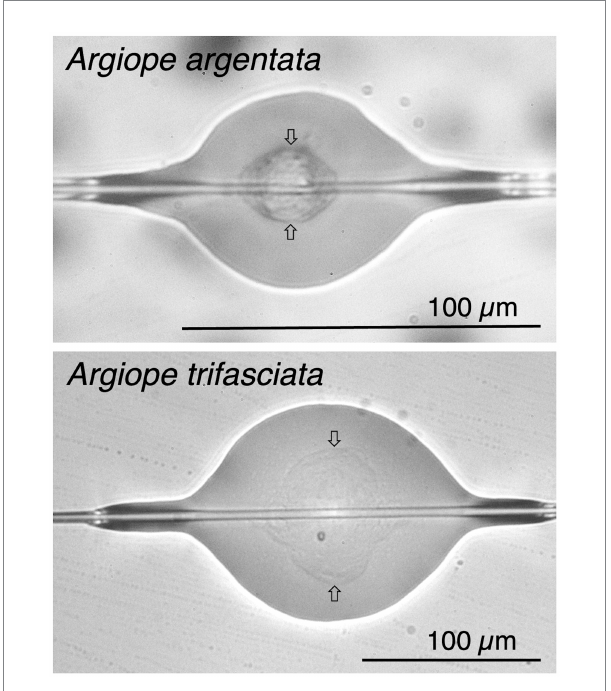
FIGURE 1 Glue droplets of Argiope argentata and Argiope trifasciata flattened at 72% relative humidity, showing each droplet’s outer aqueous layer, protein core (identified by arrows), and supporting flagelliform fiber